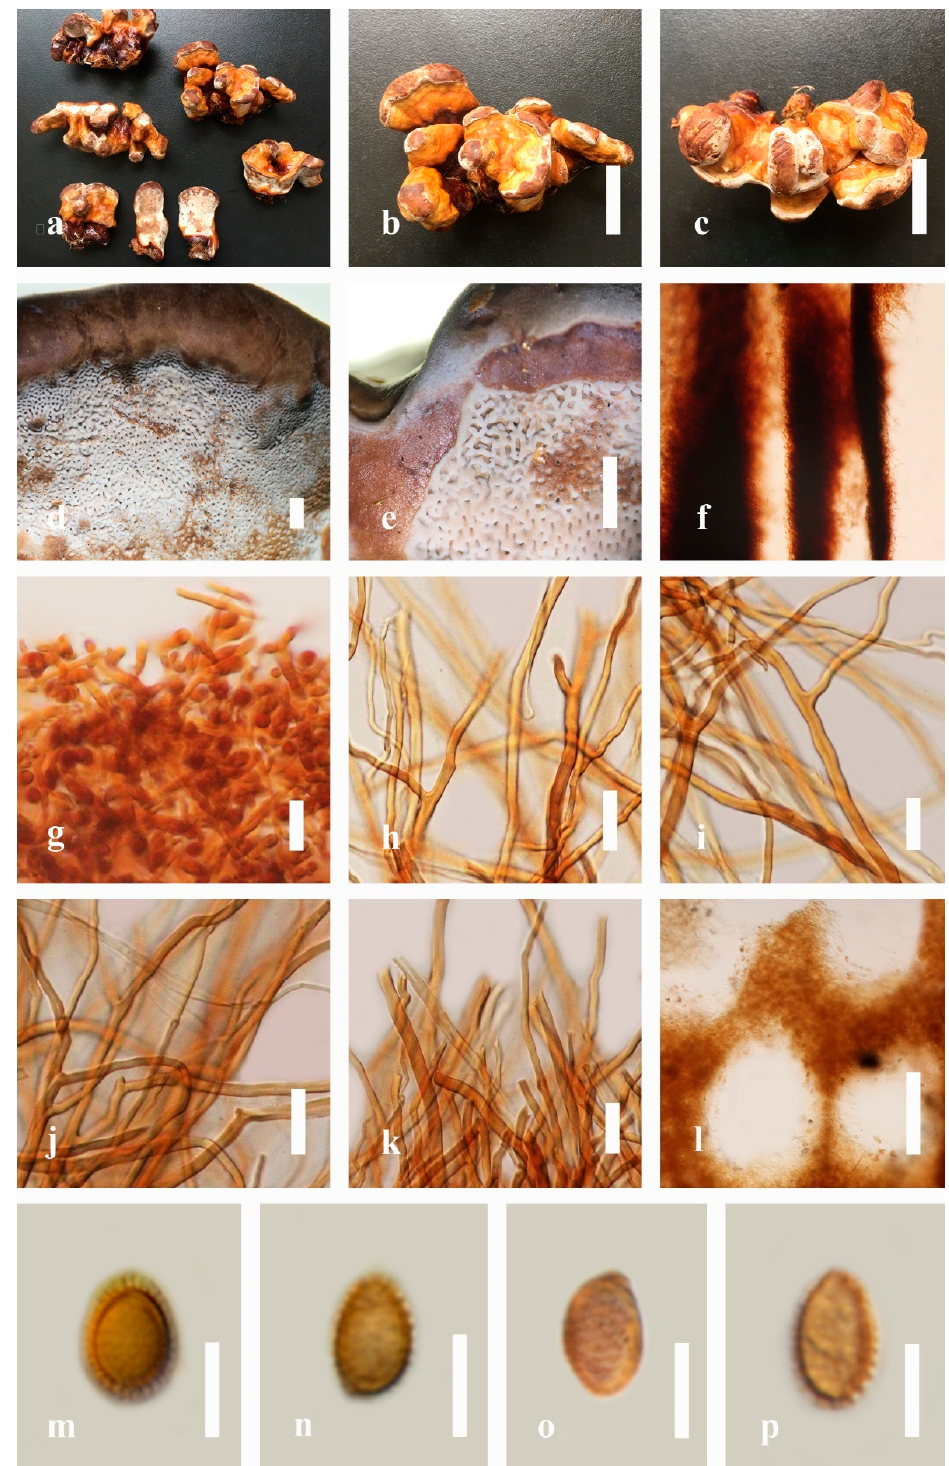
Figure 33. Characteristics of Ganoderma hochiminhense : ( a ) basidiomes of the strain MFLU 19 ‐ 2224; ( b ) mature basidiomes of the strain MFLU 19 ‐ 2224; ( c ) mature basidiomes of the strain MFLU 19 ‐ 2225; ( d , e ) pores characteristics; ( f ) tube layers; ( g ) hyphae from tube layers; ( h , i ) hyphae from context in KOH; ( j ) clamp connection from context; ( k ) hyphae from trama in KOH; ( l ) pores characteristics; ( m – p ) basidiospores in KOH. Scale bars: ( b , c ) = 2 cm, ( d , e ) = 1000 μ m, ( g – k ) = 20 μ m, L = 150 μ m, ( m – p ) = 5 μ m.